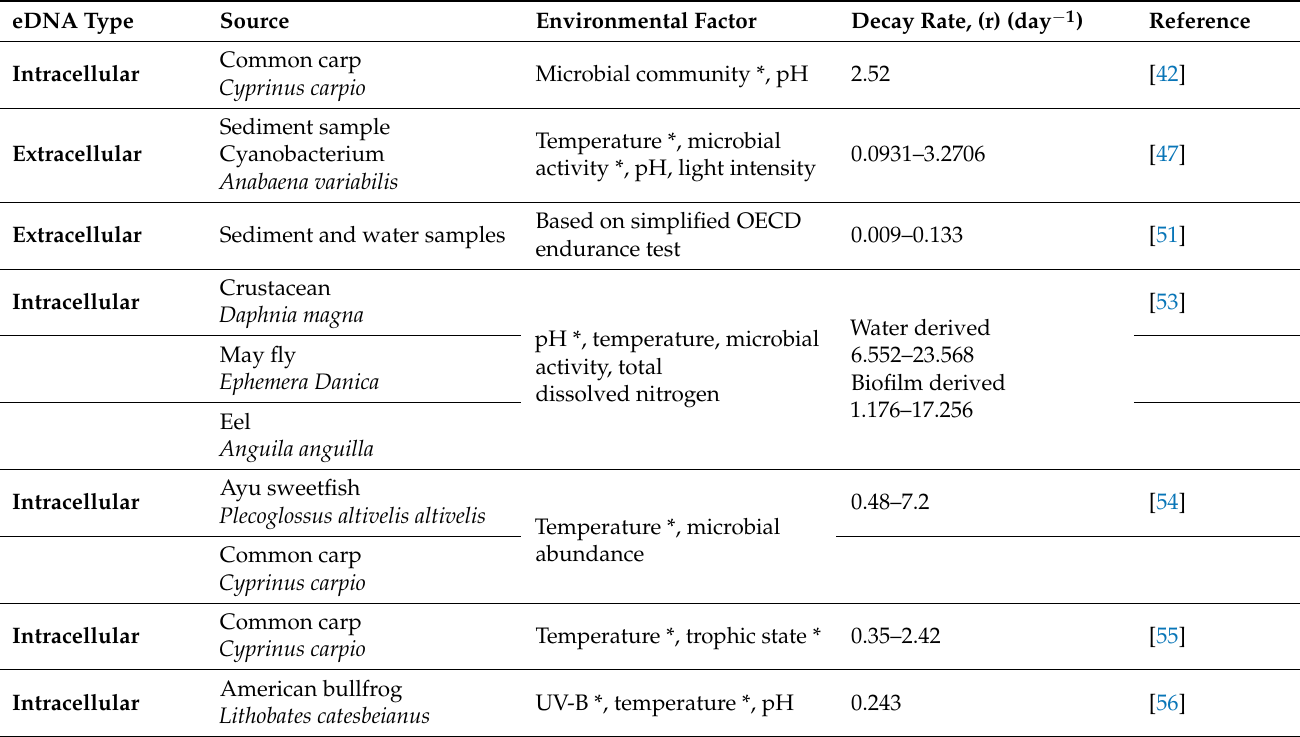
Table 2. Comparison of eDNA decay rates among various types of eDNA, sources, and environmental factors. * Indicates the significant effect on eDNA degradation in the corresponding study. (Table adapted from Zulkefli et al., 2019